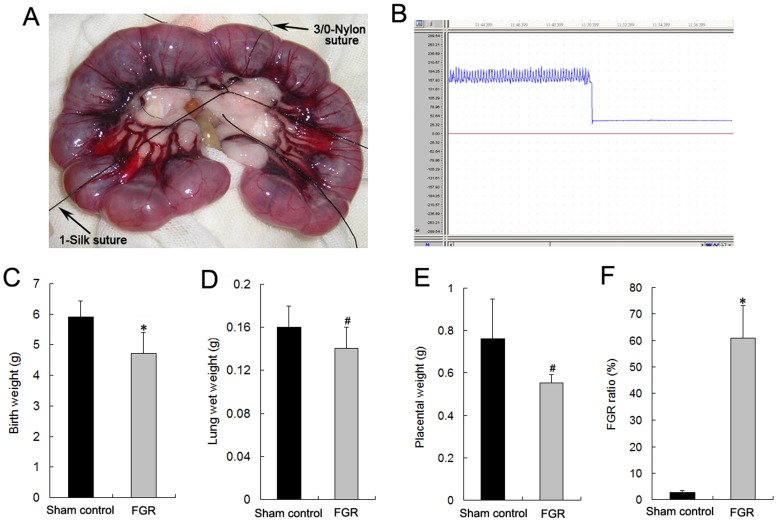
Establishment of the FGR rat model by partial ligation of bilateral uterine vessels.A and B: Bilateral uterine vessel partial ligation surgery was performed as per protocol (A) and blood pressure of the uterine artery was monitored by a physical recorder (B). C, D, and E: Birth weight (C), lung wet weight (D), and placental weight (E) of neonates were recorded for the assessment of FGR. #P<0.05 vs the sham control group (n = 10). F: In accordance with the criterion for FGR, the FGR ratio was determined by the number of FGR pups in relation to the total number of pups. *P<0.01 vs the sham control group (n = 10).